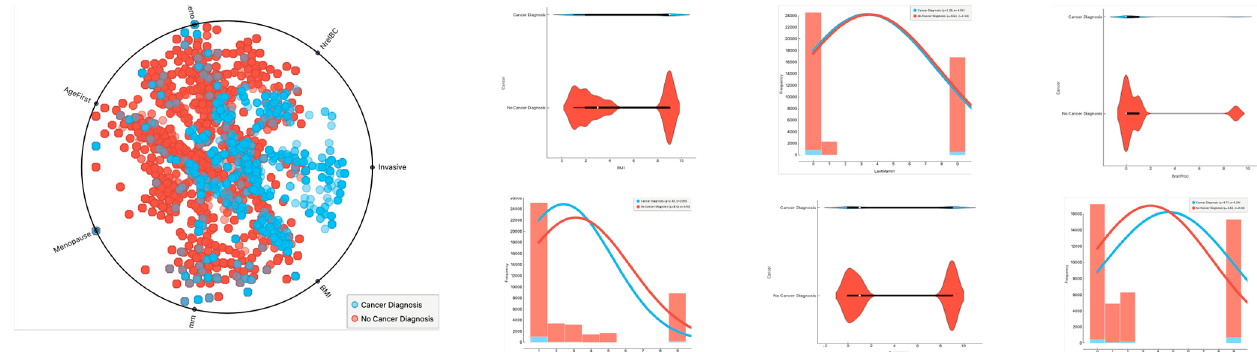
Figure 4. Illustration of BCSC dataset data properties.